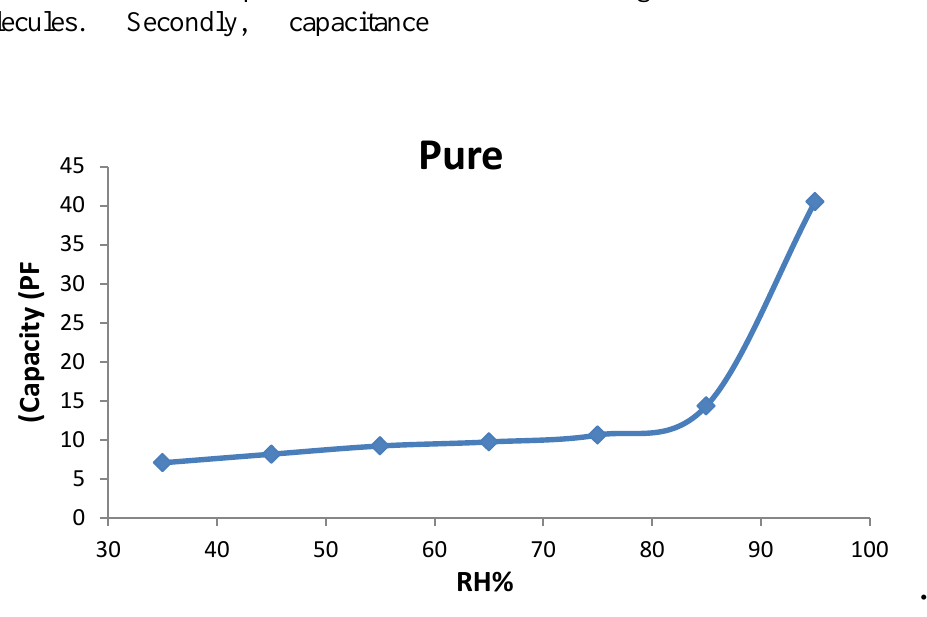
Fig.3: Humidity capacitance relationship for PANI humidity sensors.